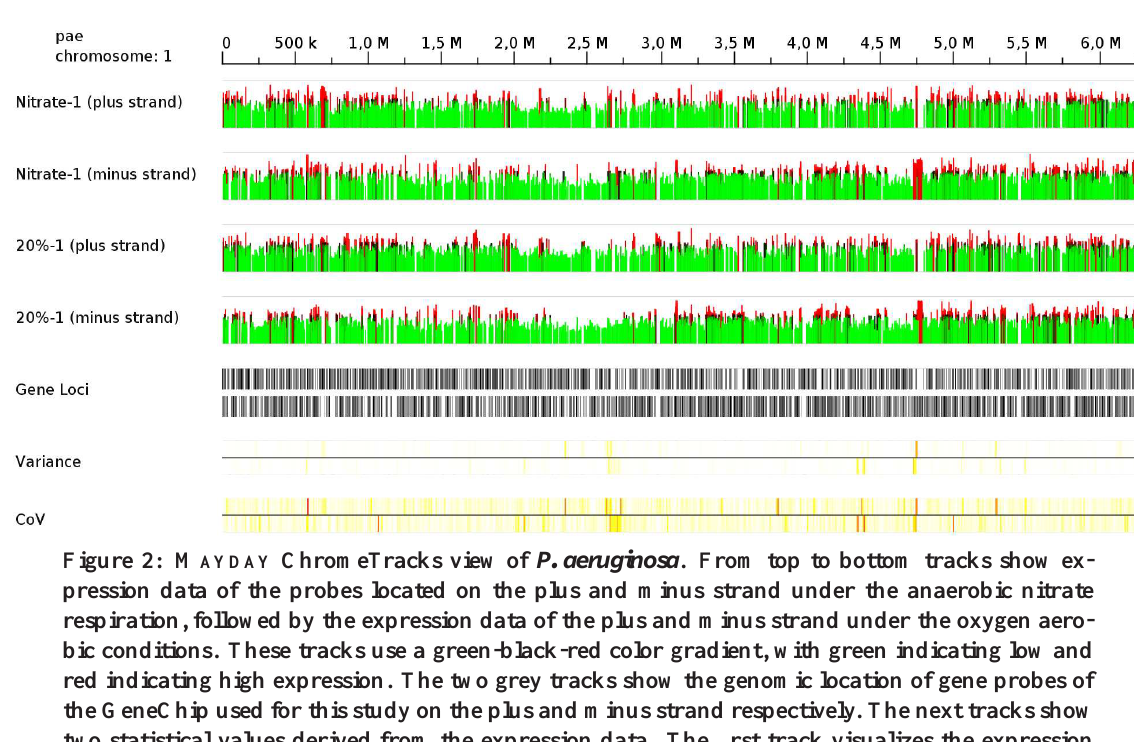
Figure 2: M AYDAY ChromeTracks view of P. aeruginosa . From top to bottom tracks show ex- pression data of the probes located on the plus and minus strand under the anaerobic nitrate respiration, followed by the expression data of the plus and minus strand under the oxygen aero- bic conditions. These tracks use a green-black-red color gradient, with green indicating low and red indicating high expression. The two grey tracks show the genomic location of gene probes of the GeneChip used for this study on the plus and minus strand respectively. The next tracks show two statistical values derived from the expression data. The first track visualizes the expression variance of each probe across the experiments followed by the coefficient of variation. Here yellow indicates low variance and low coefficient of variation,